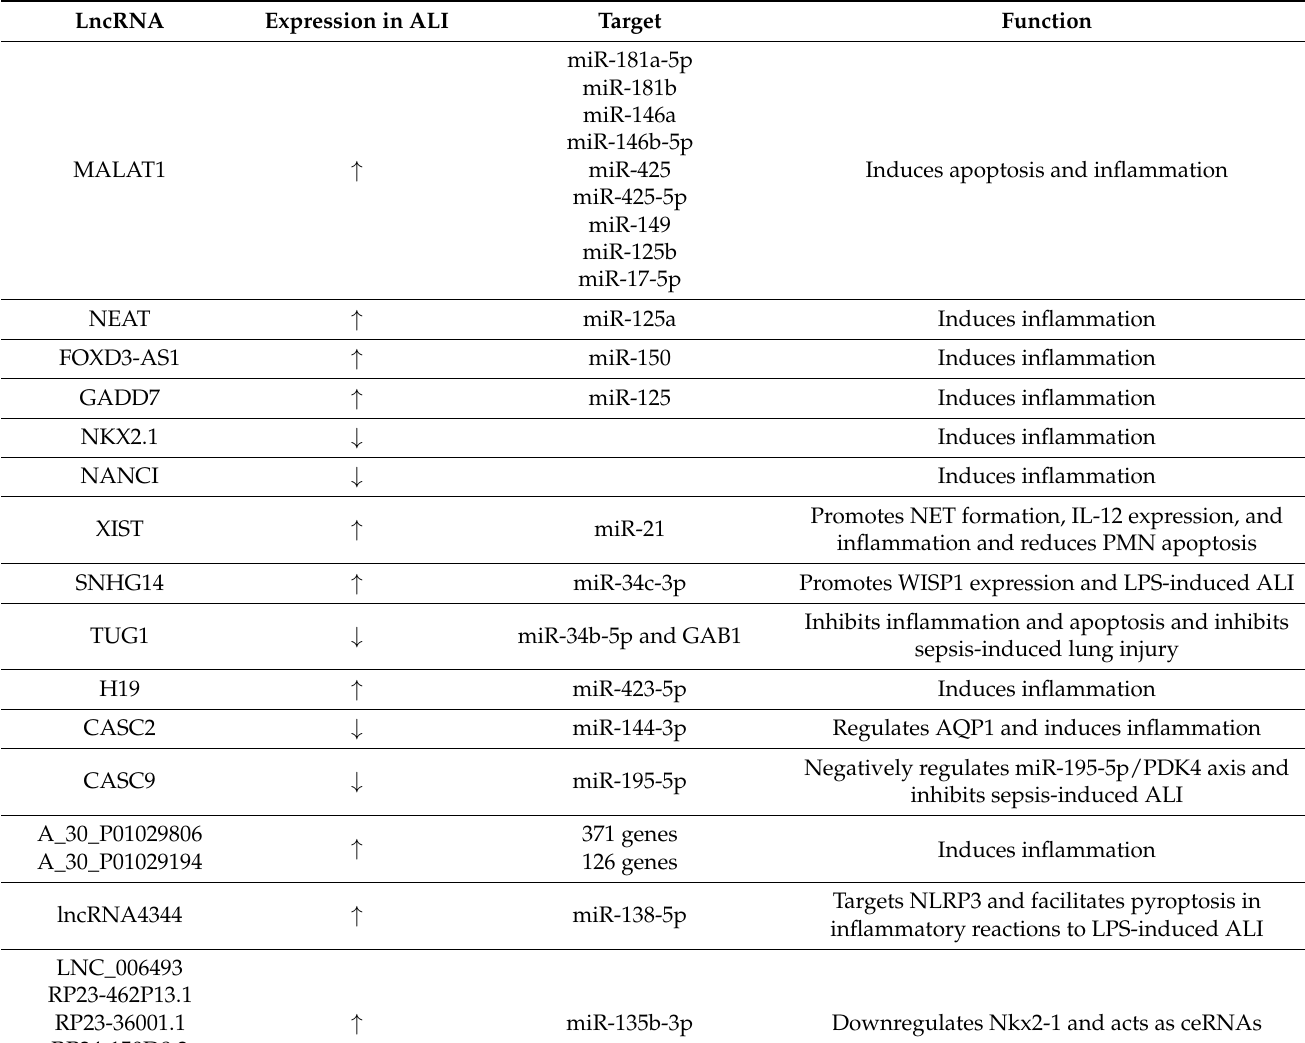
Table 1. Regulation and function of lncRNAs in